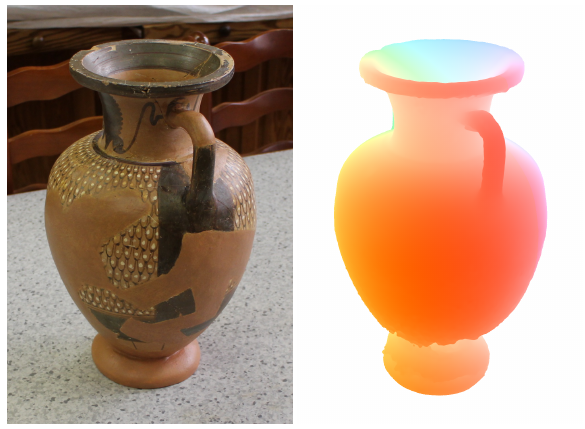
Figure 3. An image from the dataset and the corresponding ground truth optical flow